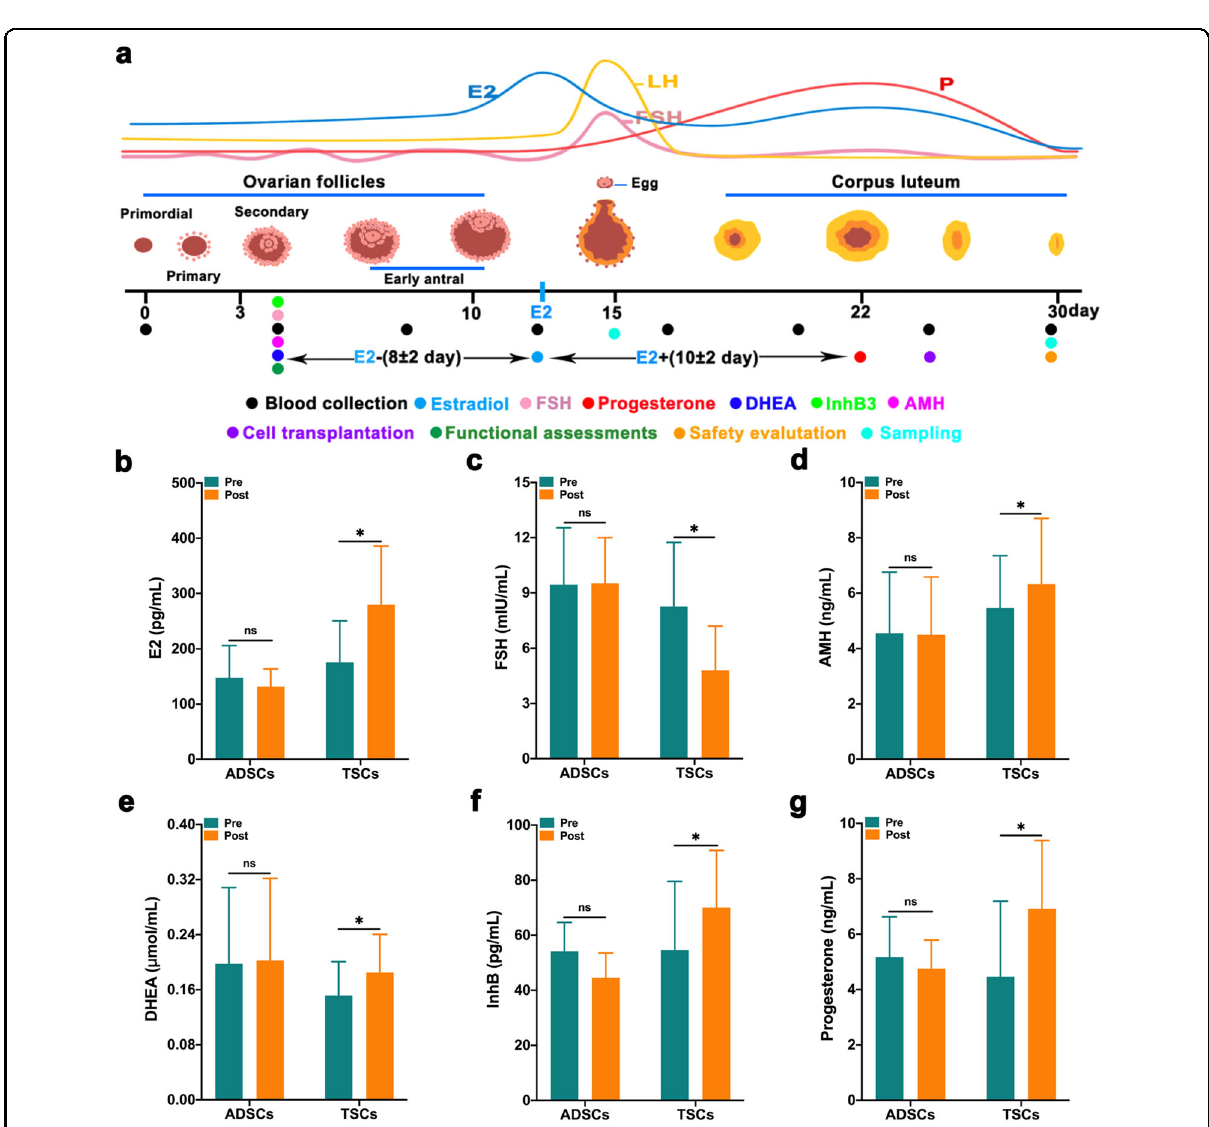
Fig. 3 TSCs transplantation improves hormone levels in monkeys with POI. a Schematic of the experimental procedure used for cell transplantation, functional and safety assessment. The black dots represent the point at which the blood was collected, and the dots in different colors represent the time selected by different functional assessments, which were all calculated based on the peak E2 time. The dark green dots represent functional assessments including ovarian, uterine and heart function. b – g Estrogen peak ( b ), follicle stimulating hormone ( c ), anti-Mullerian Hormone ( d ), dehydroepiandrosterone ( e ), InhB ( f ), and progesterone peak ( g ). The ADSCs group represents the monkeys with POI who received adipose-derived mesenchymal stem cells transplantation (ADSCs = POI + ADSCs, n = 4); the TSCs group represents the monkeys with POI who received thecal stem cells transplantation (TSCs = POI + TSCs, n = 6). Data are expressed as the means ± SEM and were assessed using t -test; * P < 0.05, ns not signi fi